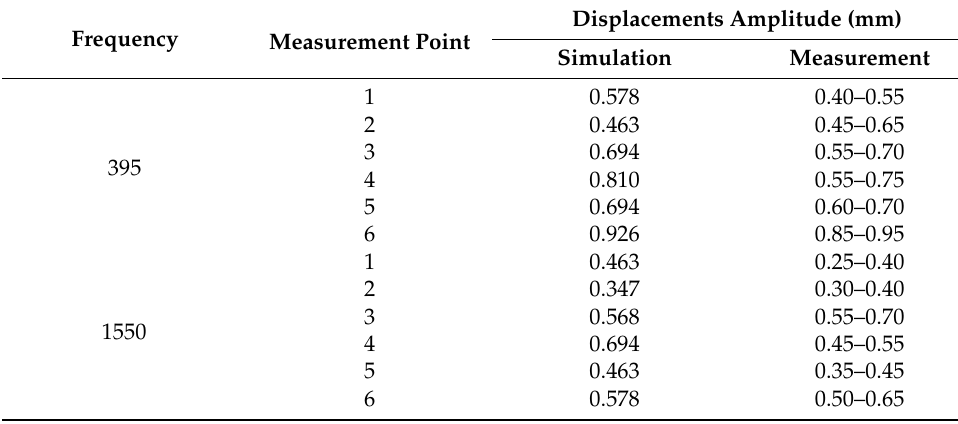
Table 5. Comparison of the measured and calculated values for